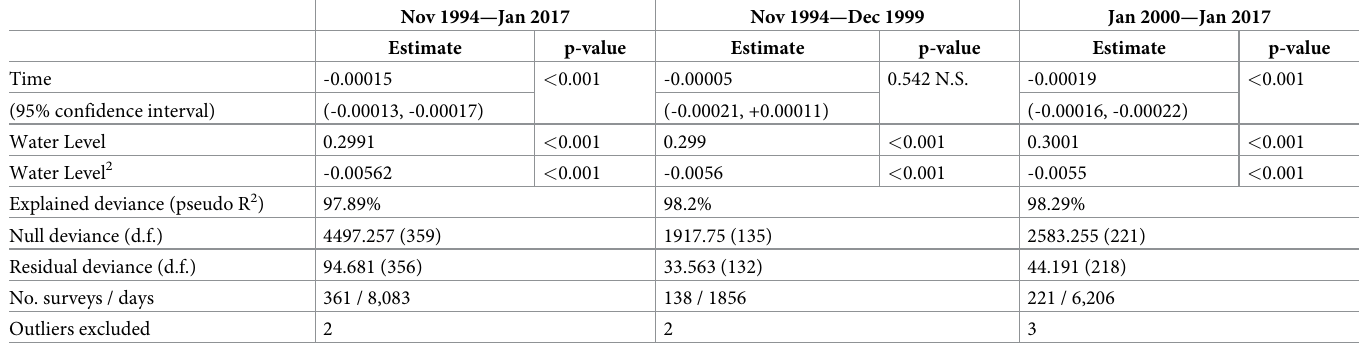
Table 1. Model results for boto counts. The unit of time is one day, so a coefficient of -0.00015 represents a decline in the number of encountered botos of 0.015% per day, or 5.48% per year during the entire sampling